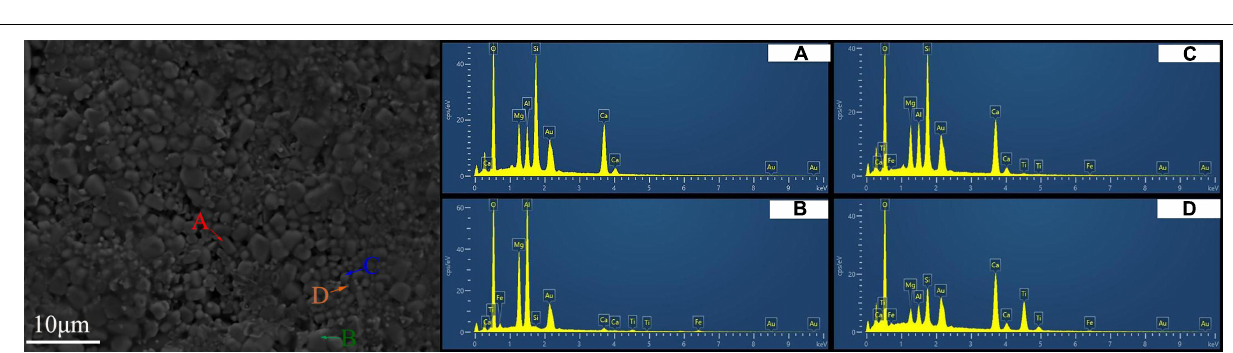
FIGURE 4 | Energy dispersive spectrometer images of EBFS-1180